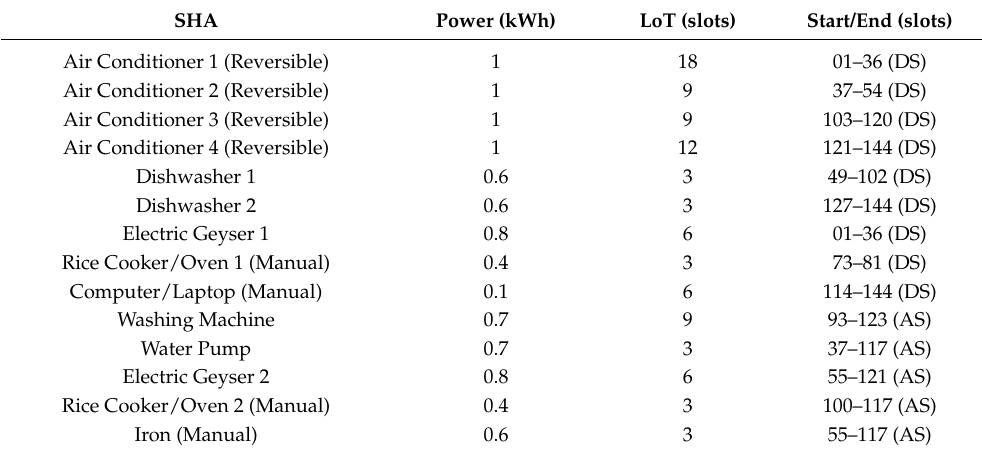
Table 5. Shiftable home appliances and scheduling specifications.